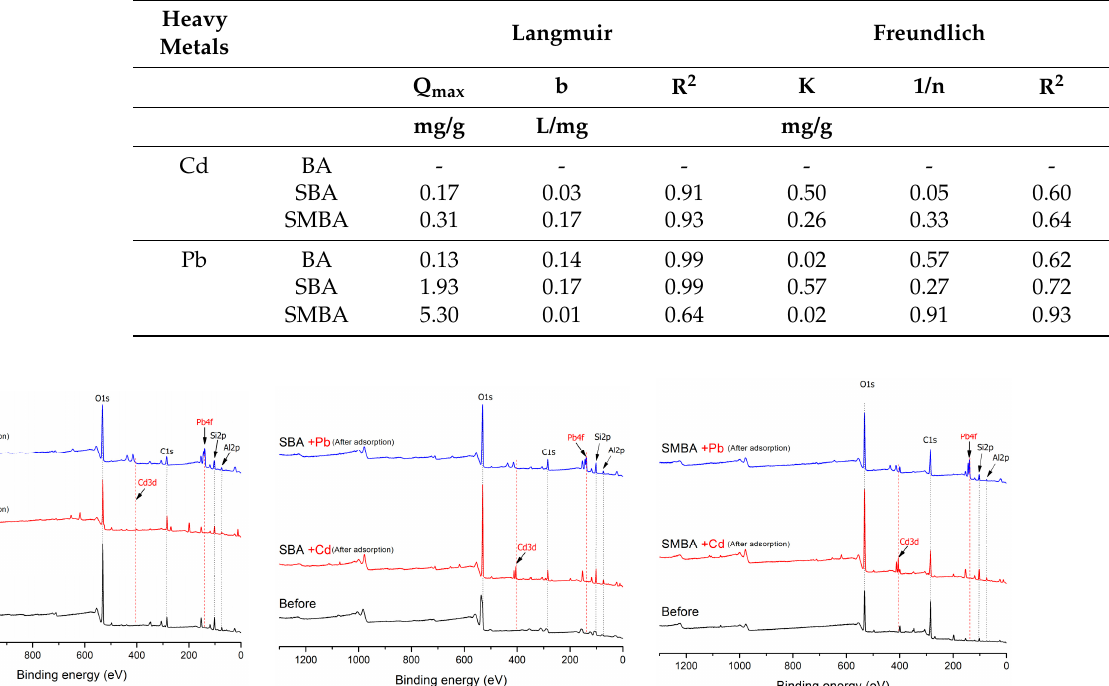
Table 3. Sorption isotherm parameters for varied sorption materials.